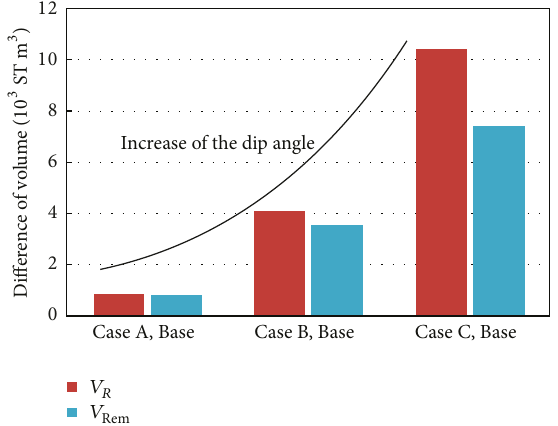
Figure 9: The difference of the cumulative volume of methane released from hydrate dissociation ( 𝑉 𝑅 ) and methane remaining in the reservoir ( 𝑉 Rem ) between horizontal strata and those sloping formations at the end of 5-year production